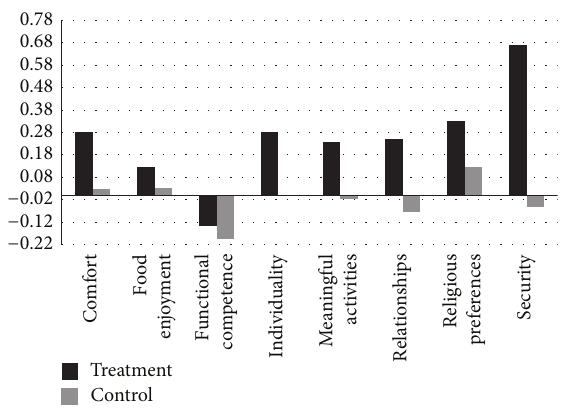
Figure 2: Change in quality of life domain scores by QOL care plan target.